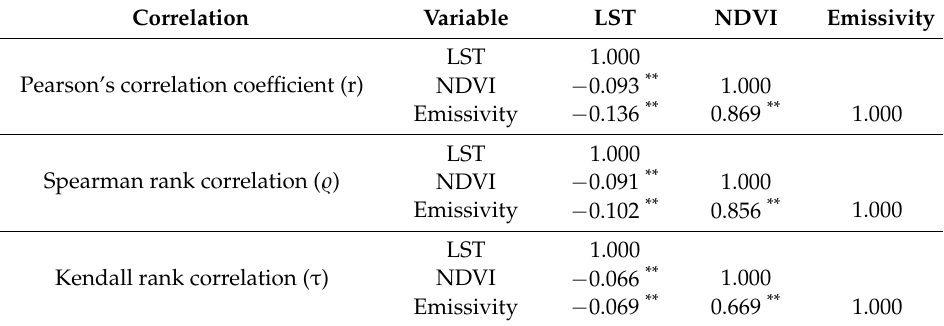
Table 4. Parametric (Pearson’s r) and non-parametric (Spearman’s (cid:36) and Kendall’s τ ) correlation for Landsat derived variables in L2 transect. Number of samples =